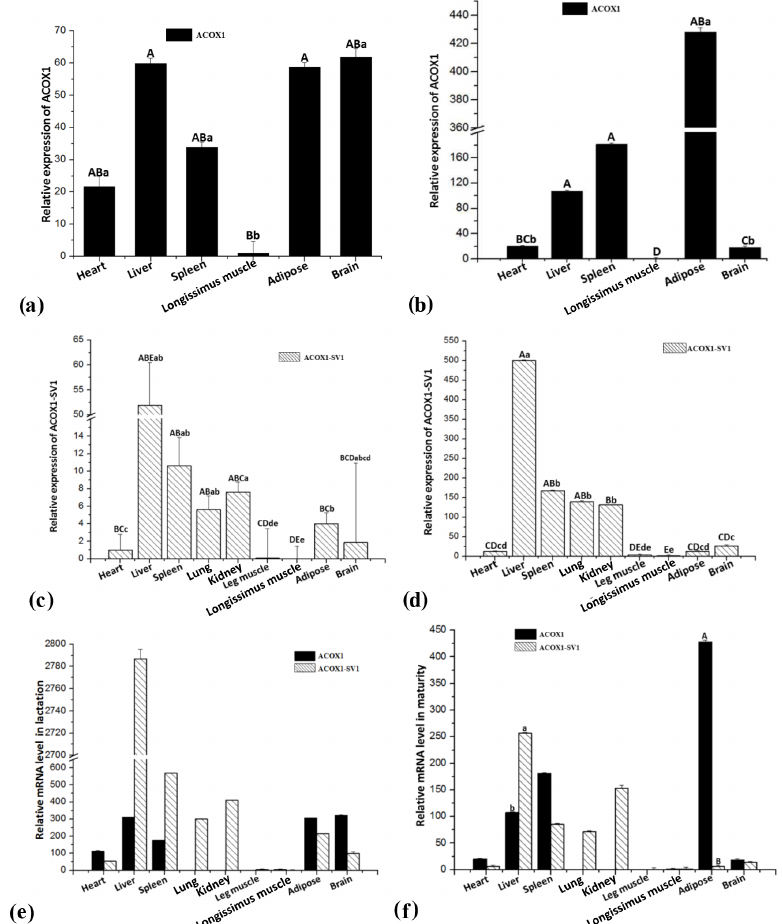
Figure 7. Relative ACOX1 and ACOX1-SV1 mRNA levels in the kids (a, c) and adults (b, d) , and differential expression levels of two different transcripts in various tissue types of kids (e) and adults (f) . Note: gene expression was normalized using GAPDH as a reference gene. Uppercase letters represent statistical significance at P < 0 . 01, and lowercase letters represent the statistical significance at P < 0 . 05.